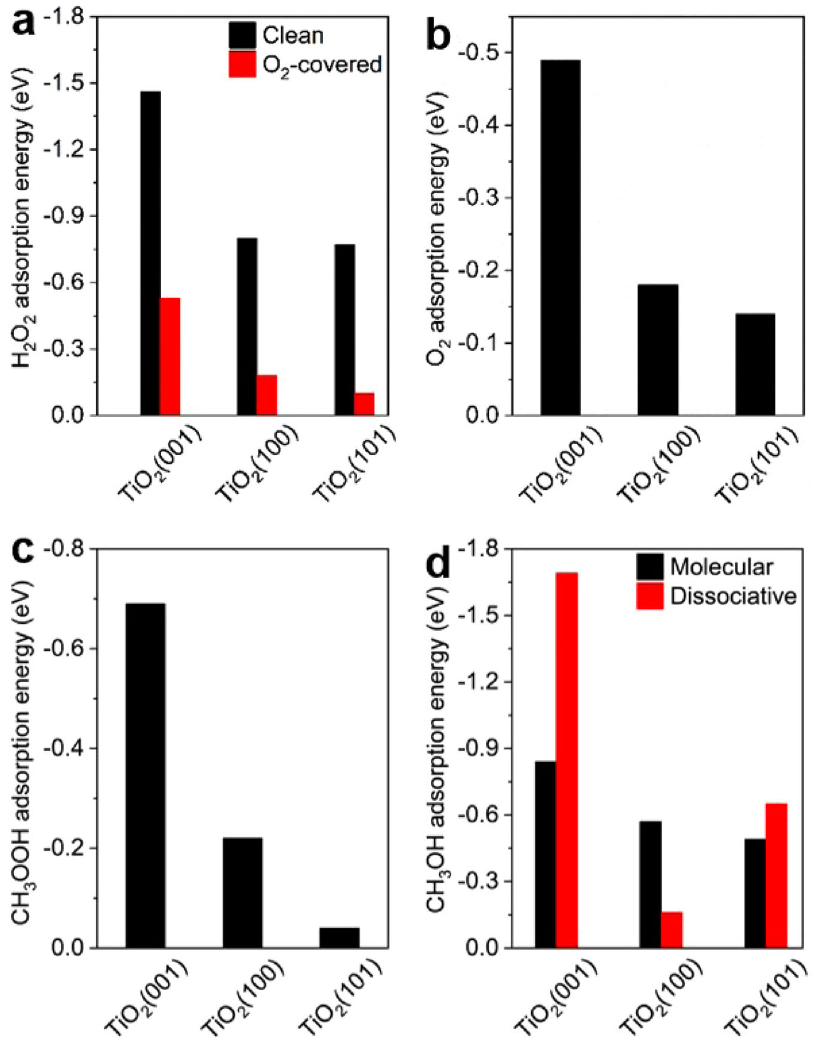
Fig.5|DFTcalculations. Calculatedadsorptionenergiesof( a )H 2 O 2 oncleanandO 2 -coveredTiO 2 (001),(100)and(101)surfaces,( b )O 2 ,( c )CH 3 COOHand( d )molecular and dissociative CH 3 OH adsorption on TiO 2 (001), (100) and (101) surfaces. Source data are provided as a Source Data fi